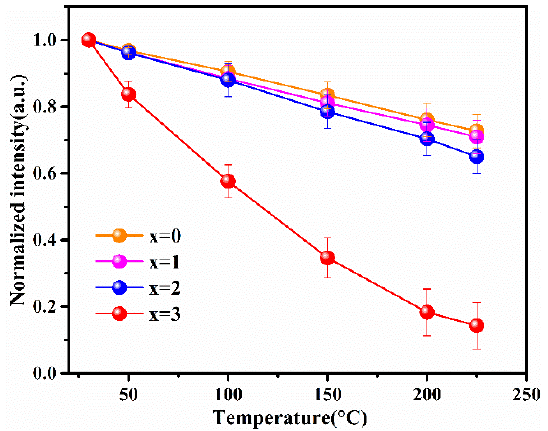
Figure 6. The thermal quenching behavior in the Lu 3 Ga x Al 5 − x O 12 : Ce 3+ (x = 0, 1, 2, 3) phosphors sintered at 1450 °C.